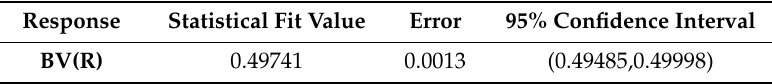
Table 2. Statistical fit and confidence interval for bed velocity response.